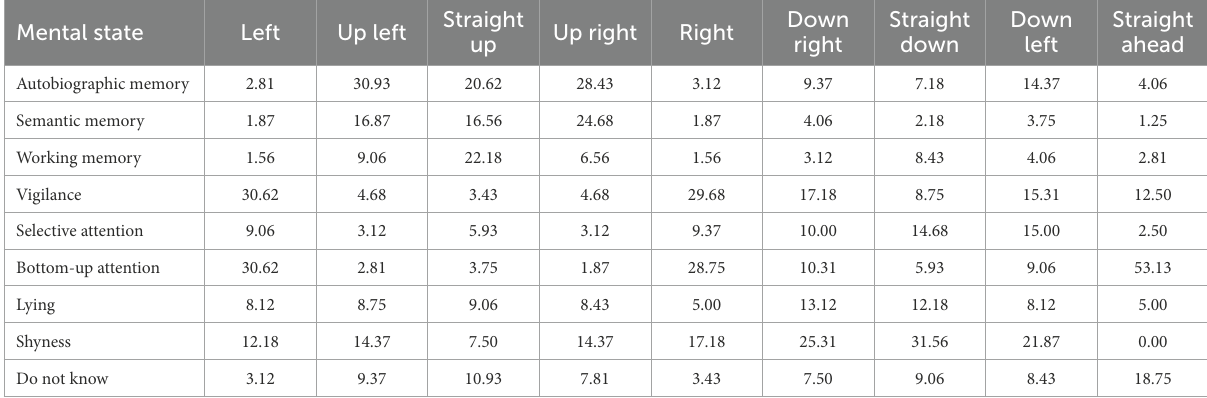
TABLE 2 Frequencies of responses (in %) during Experiment 1a for the different gaze directions. Mental state Left Up left